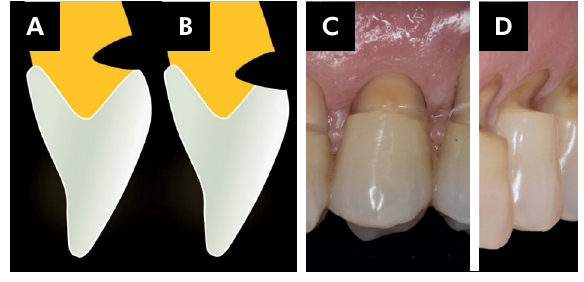
Figure 7. Schematic view of the A+V and B+V defects (a, b; respectively). There is a V-shaped non-carious cervical lesion (NCCL) associated with gingival recession affecting either only the root surface (a) or both crown and root surfaces (b). Representative clinical case, facial (c) and lateral (d) views of a combined defect with B+V NCCL.